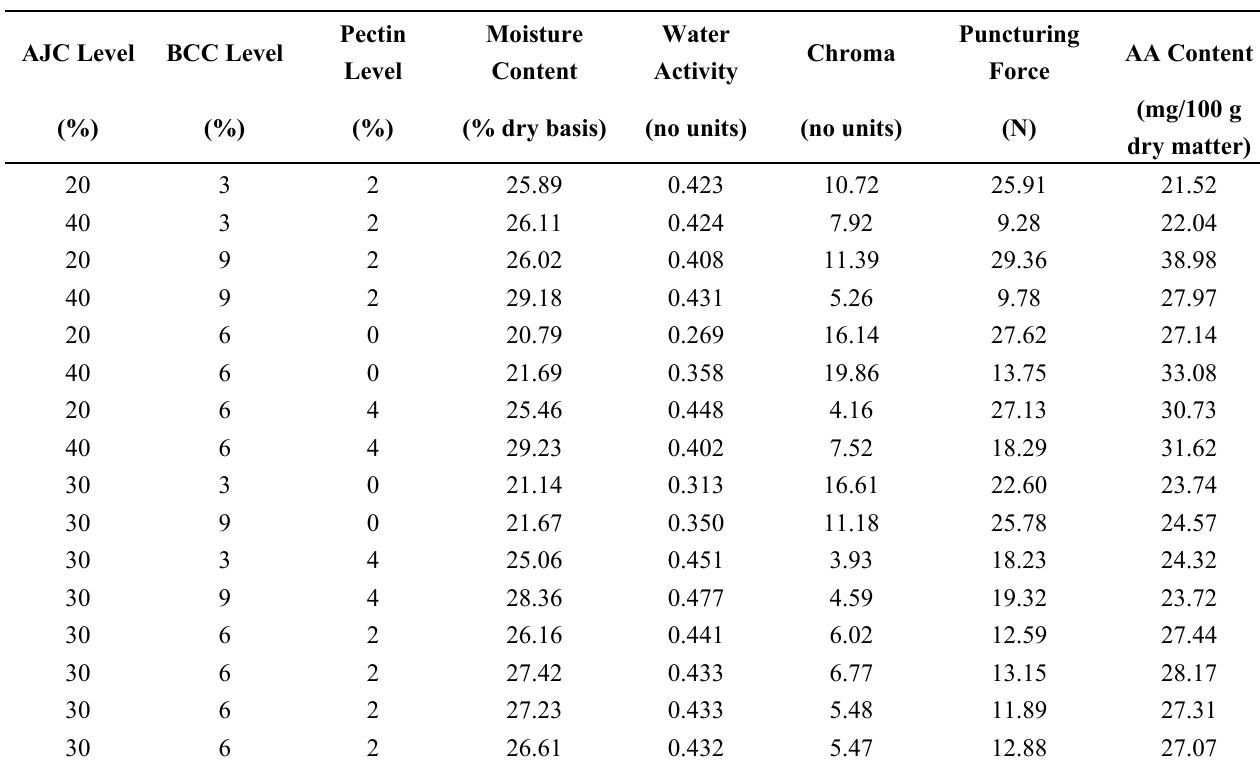
Table 2. Mean results of the response surface methodology experiments on the qualities of apple-blackcurrant fruit leather as affected by apple juice concentrate (AJC), blackcurrant concentrate (BCC) and pectin